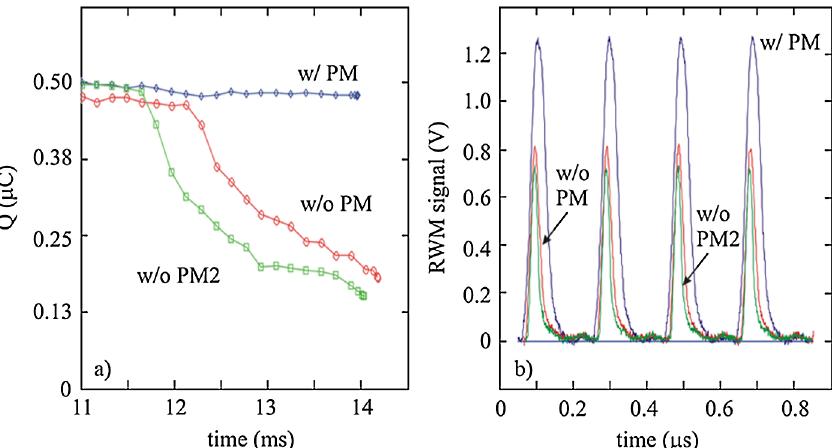
FIG. 1. (Color) RWM data: (a) Integrated current showing charge behavior with rf phase modulation and for two cases without phase modulation. Note that beam loss begins earlier for the higher charge cycle; (b) instantaneous current signals for the same three cases shown in (a) shortly before extraction.